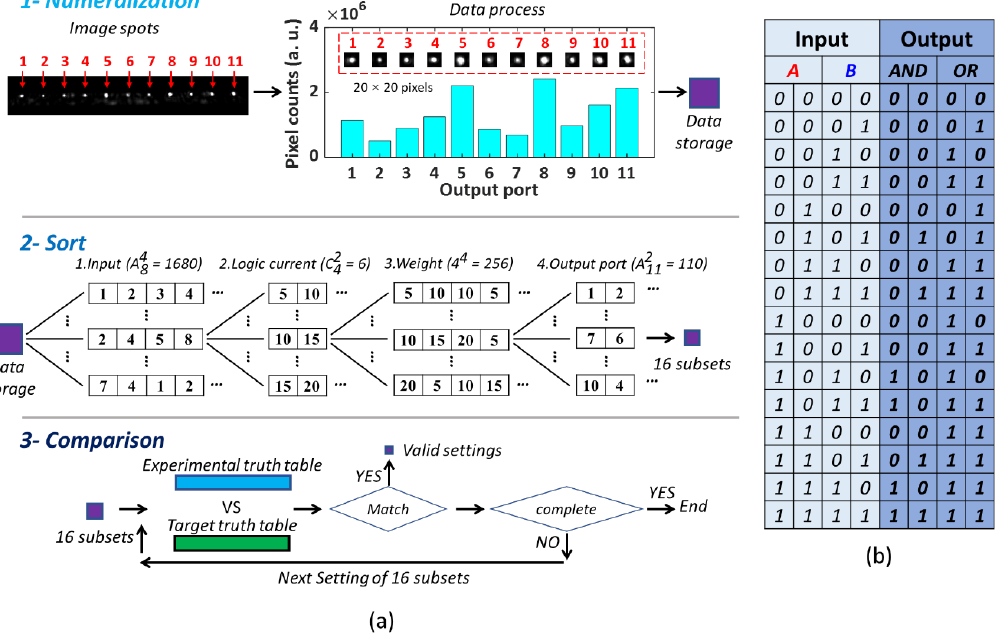
Figure 4. ( a ) Data sorting algorithm to find the valid settings that match the truth table. ( b ) The target truth table for the two-bit AND and OR logic operation. truth table for the two-bit AND and OR logic